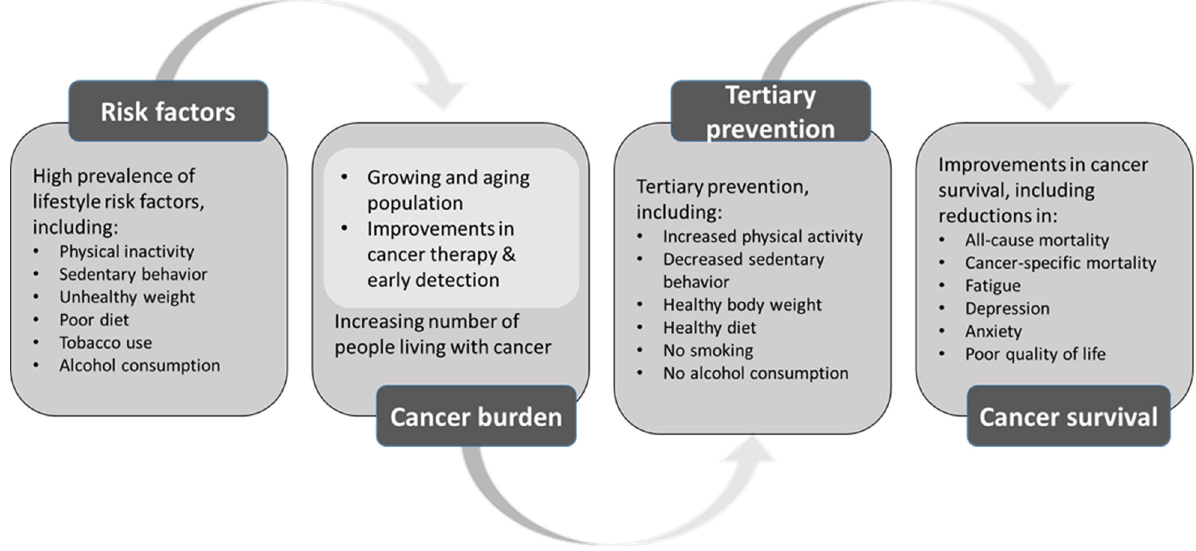
Figure 1. The role of lifestyle risk factors for the cancer burden, and the potential of tertiary prevention for improved cancer-related outcomes.